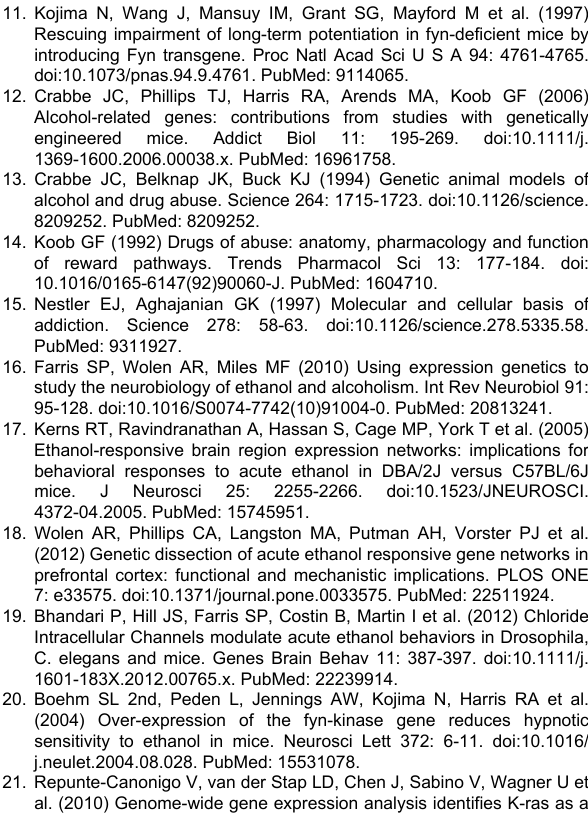
Table S7. Functional over-representation analysis of ethanol-responsive gene expression correlations with